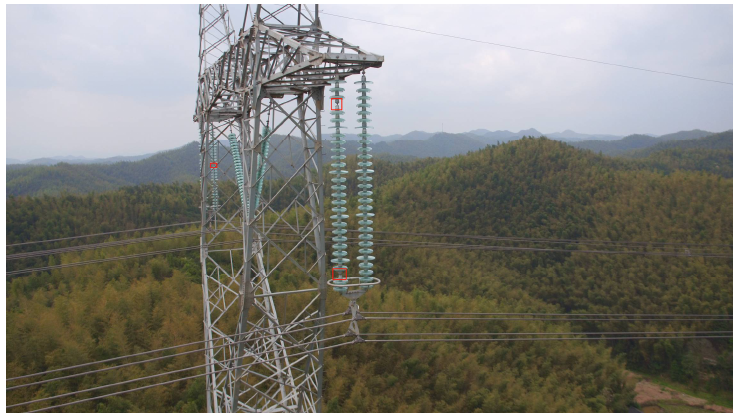
Figure 3. Self-exploding insulator in image.